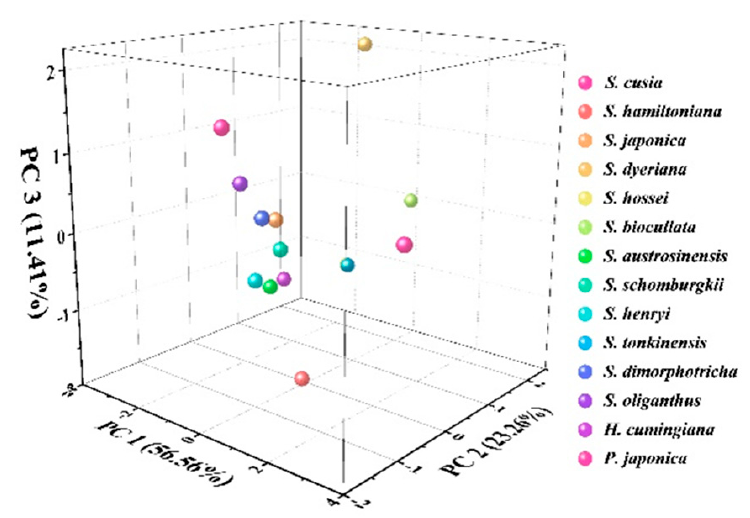
Figure 5. PCA analysis of S. hossei, S. japonica, S. dimorphotricha, S. cusia, S. biocullata, S. oliganthus, S. hamiltoniana, S. austrosinensis, S. henryi, S. tonkinensis, S. schomburgkii, S. dyeriana, H. cumingiana and P. japonica .